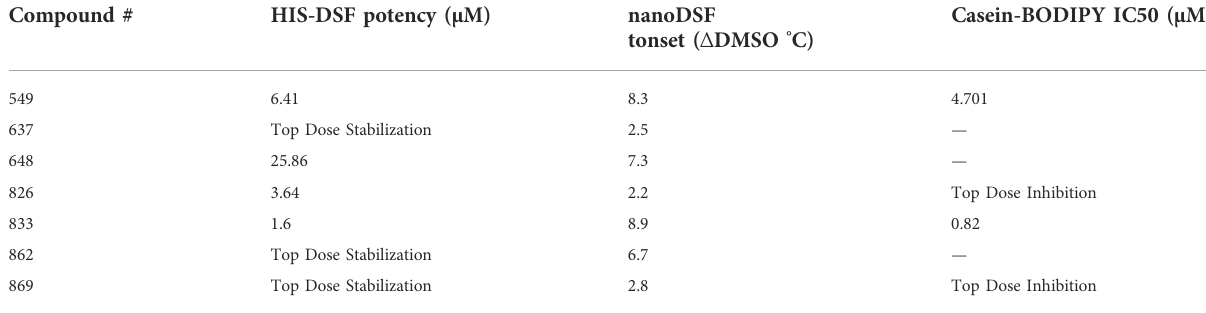
TABLE 1 Compilation of assay measurements for validated hits from the HIS-DSF screen. Compound